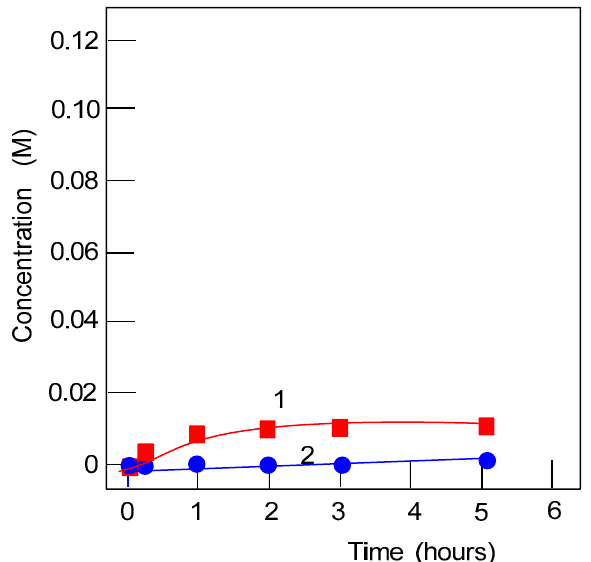
Figure 11. Oxidation of cyclohexane with hydrogen peroxide (50% aqueous) catalyzed by compound 17 in MeCN at 60 °C; Concentrations of cyclohexanone and cyclohexanol were after reduction of the aliquots with solid PPh 3 . Points for cyclohexanol (red) and cyclohexanone (blue) are marked by numbers 1 and 2, respectively. Total yield of products 2.5% after 2 h, TON = 22. Adapted from Ref. [72], Copyright (2020) with permission of Elsevier.